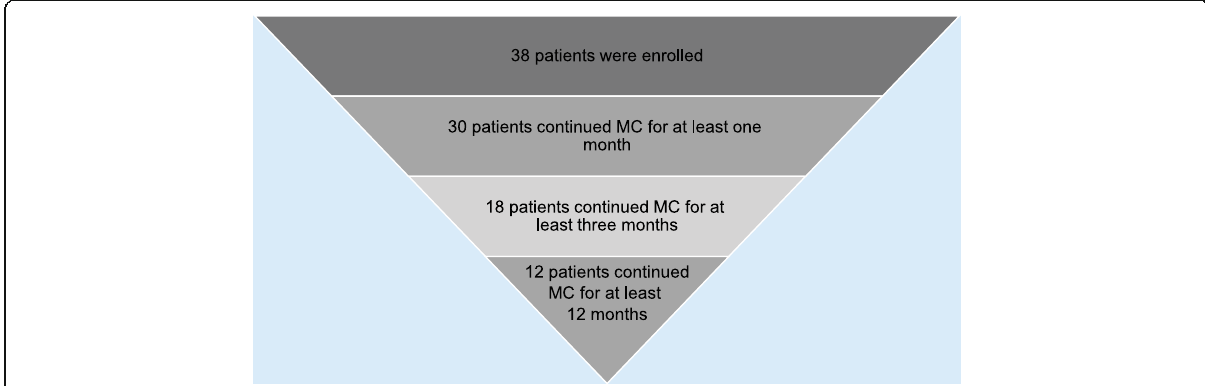
Fig. 2 Number of patients enrolled and assessed at 1, 3, and 12 months. The number of patients affected by fibromyalgia syndrome continuing MC treatment for 1, 3, and 12 months in an Italian pain clinic. MC medical cannabis